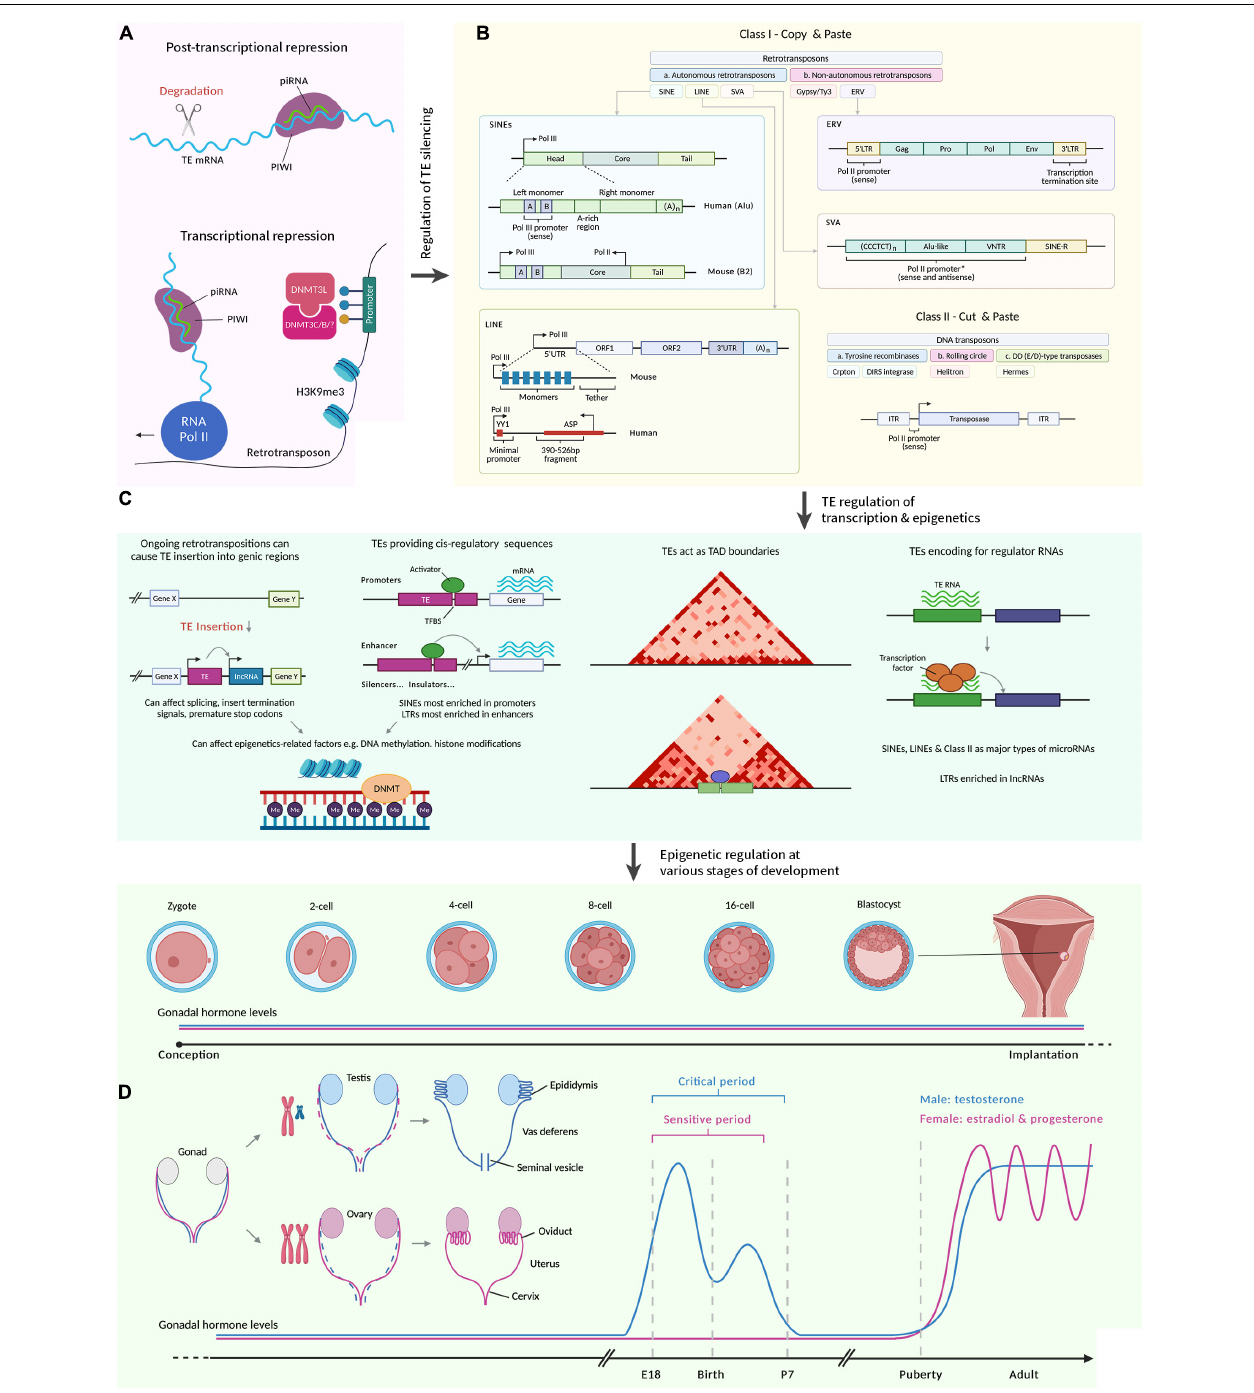
FIGURE 1 | A summary illustrating how transposable elements regulate sexual development. Figures were adapted from various sources (McCarthy, 2020; Hermant and Torres-Padilla, 2021; Senft and Macfarlan, 2021; Almeida et al., 2022; Fueyo et al., 2022). Created with BioRender.com by Stephen Renjie Hu. (A) Regulation of TE silencing through post-transcriptional and transcriptional mechanisms. PIWI proteins are loaded with piRNAs to target sequence-specific TEs. The TEs are then degraded. Transcriptionally, piRNAs can recruit chromatin remodelers (e.g., DNMT) to silence TEs. (B) There are broadly two classes of TEs. Class I refers to retrotransposons that reverse transcribe before integration (“copy and paste”). Class II refers to DNA transposons that are excised and inserted (“cut and paste”). Class I is further divided into LTRs and is mostly ERV in mammals. ERV contain two LTRs that flank ORFs, which encode viral proteins. Class I TEs that lack LTRs are LINEs, SINEs (require LINE proteins to mobilize) and SVA (primate-specific). Boxes represent the different parts of the elements. L1 contain two ORFs,